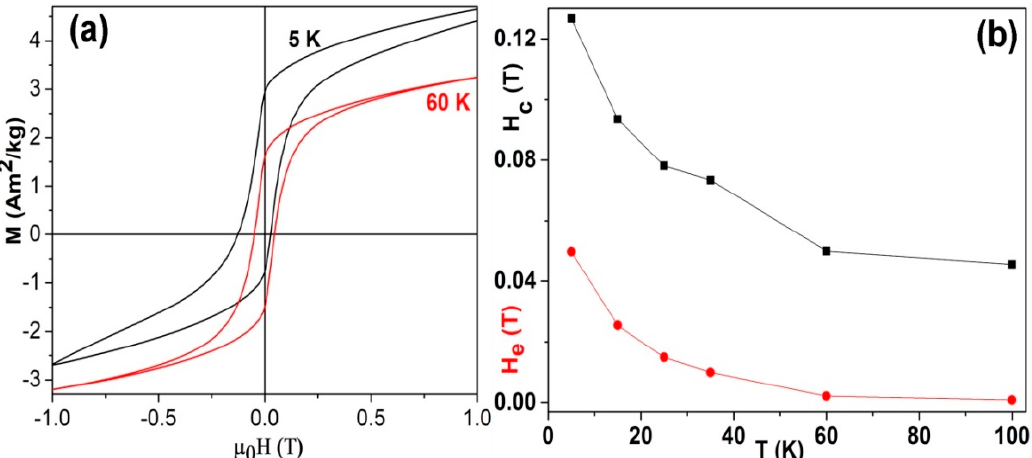
Figure 4. ( a ) The typical field-cooling (1 T) M-H curves and ( b ) the temperature dependence of exchange bias (H e ) and coercivity (H c ) of the Mn–C nanoparticles.